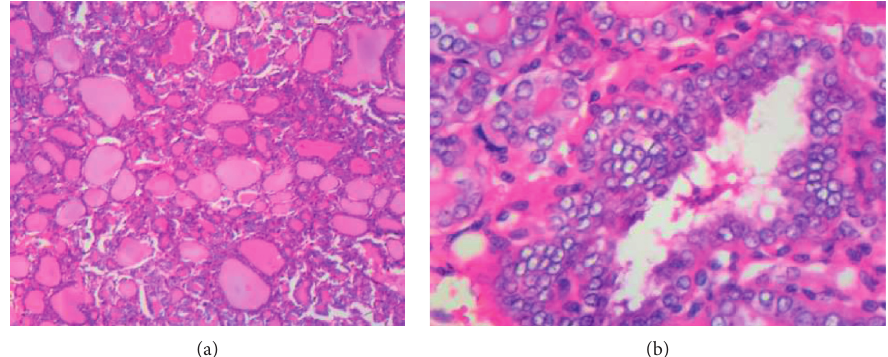
Figure 3: (a) Thyroid tumour with papillary and follicular pattern; (b) typical nuclear features of PTC: nuclear overlapping, clearing, and occasional grooves.